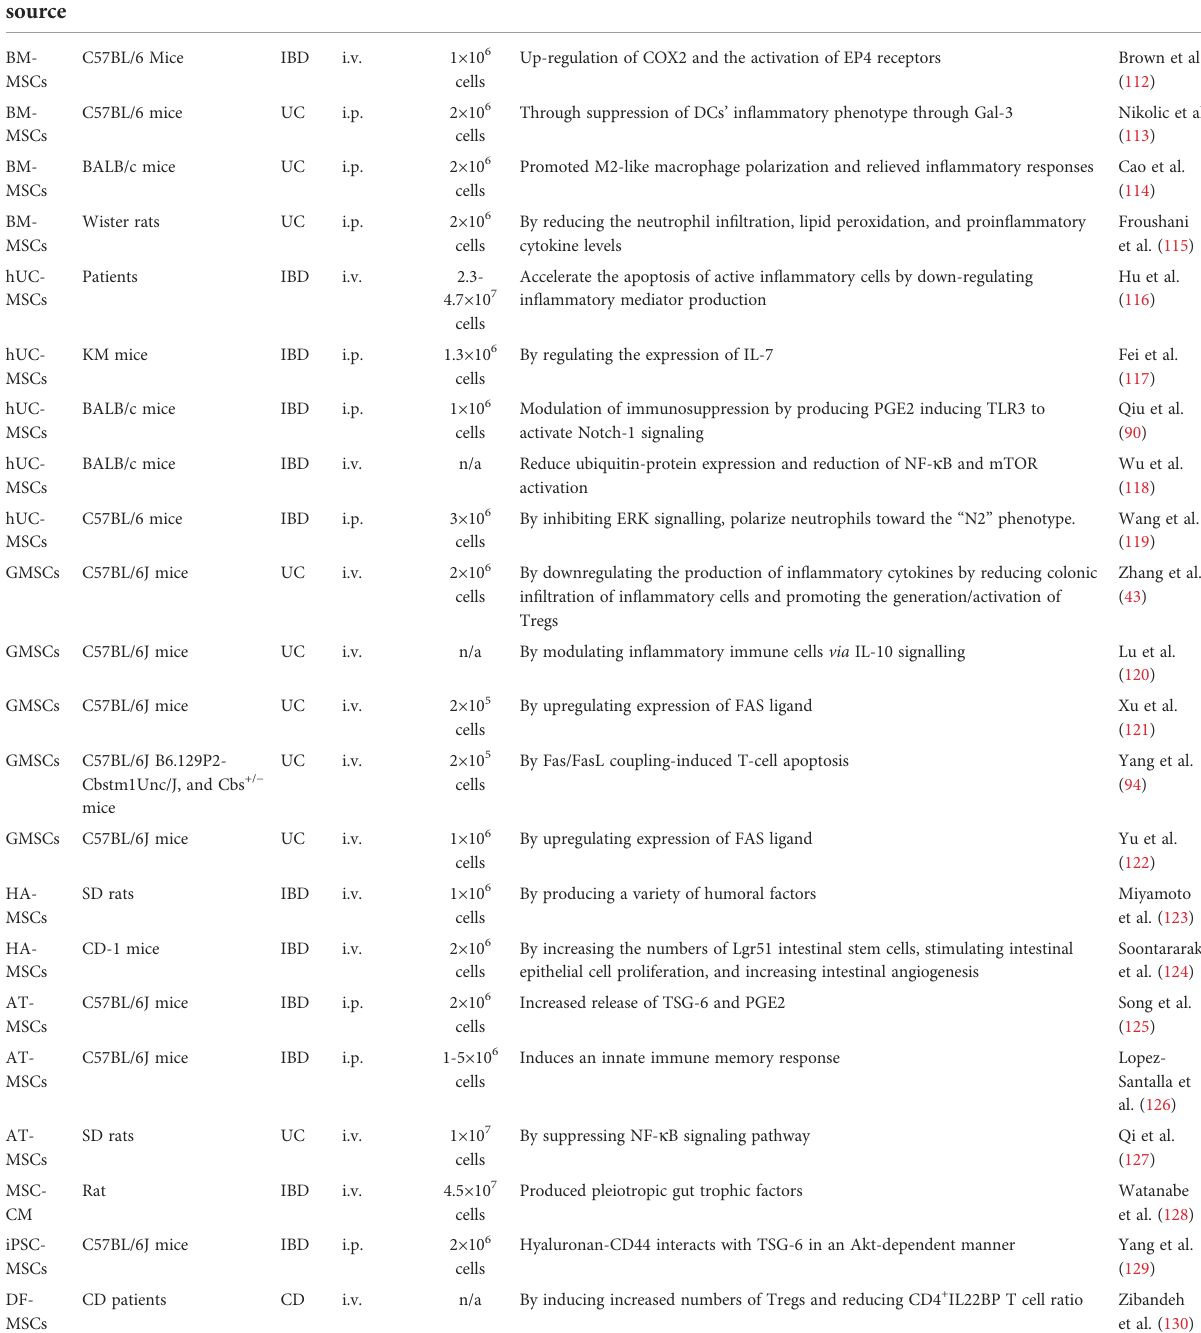
TABLE 2 The mechanism of difference source of MSCs in treatment In fl ammatory Bowel Disease. MSCs